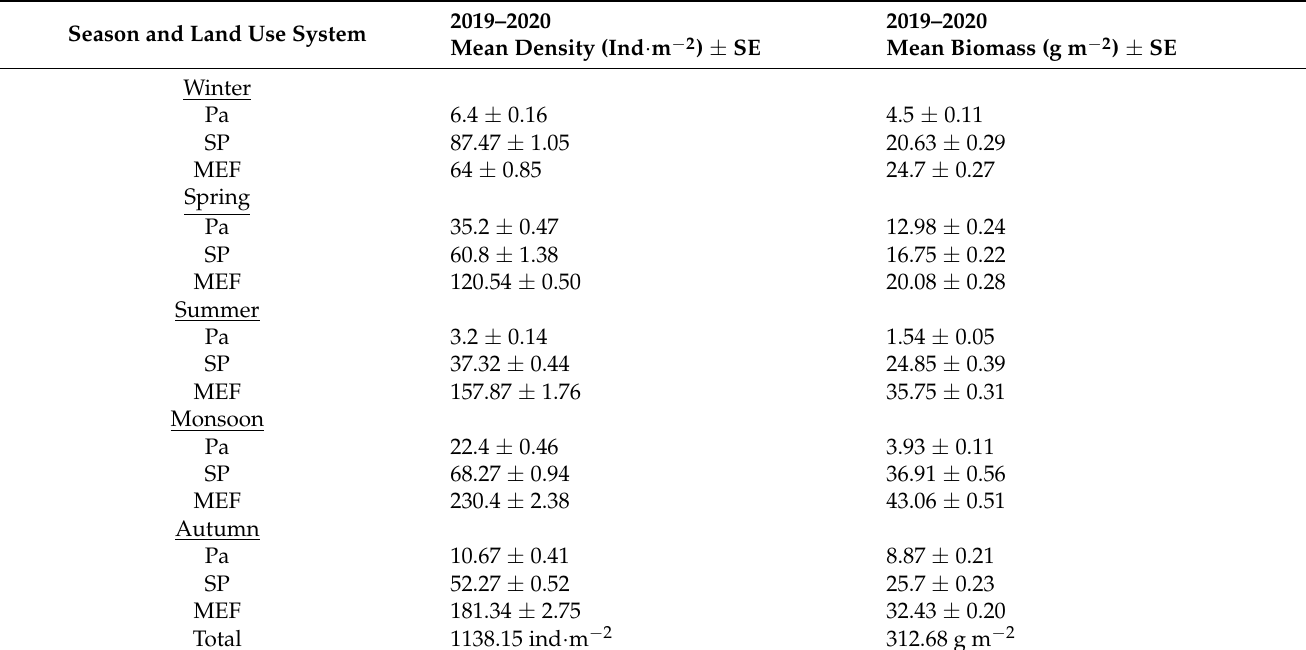
Table 7. Density (ind · m − 2 ) and biomass (g m − 2 ) of earthworms across different land use